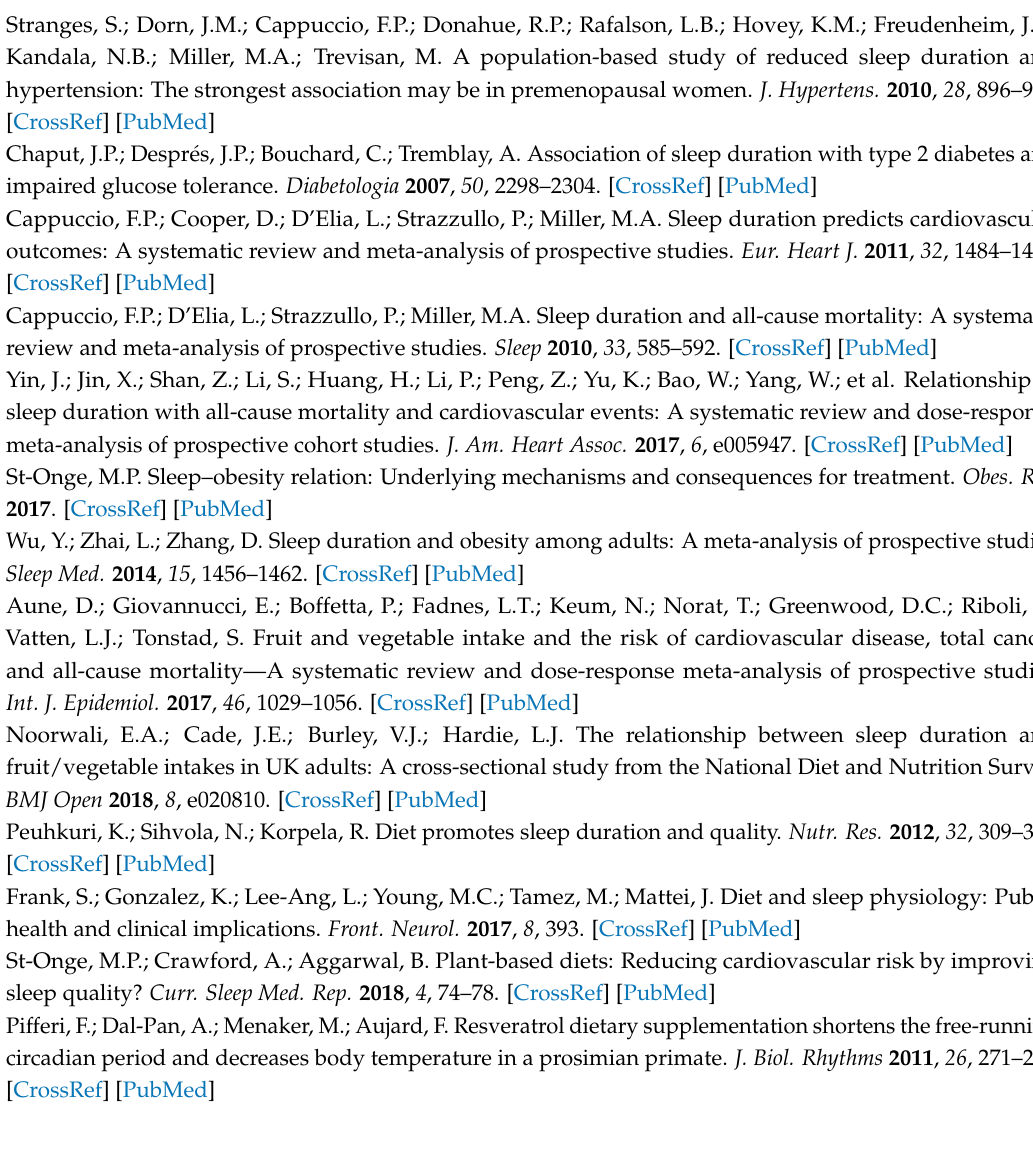
Table 3 due to available data of physical activity and sleep duration of only 8177 women and difference in ( n ) is due to missing data of any of the included covariates in the